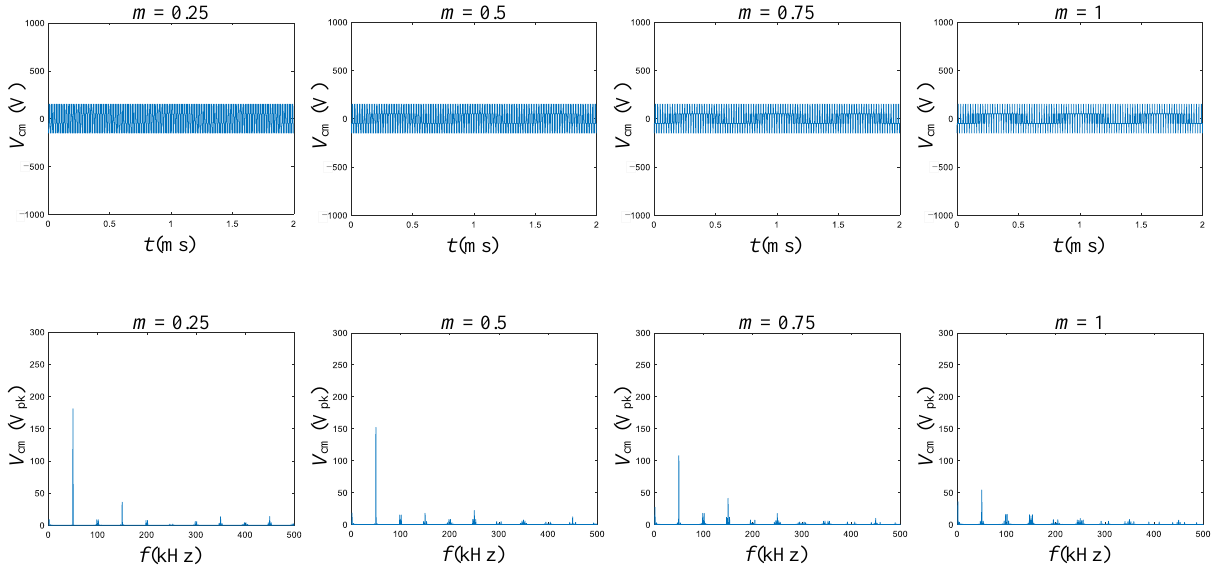
Figure 10. Time-domain and frequency-domain plots of the common-mode voltage in EV 1 under different modulation index values. Designs A and B.